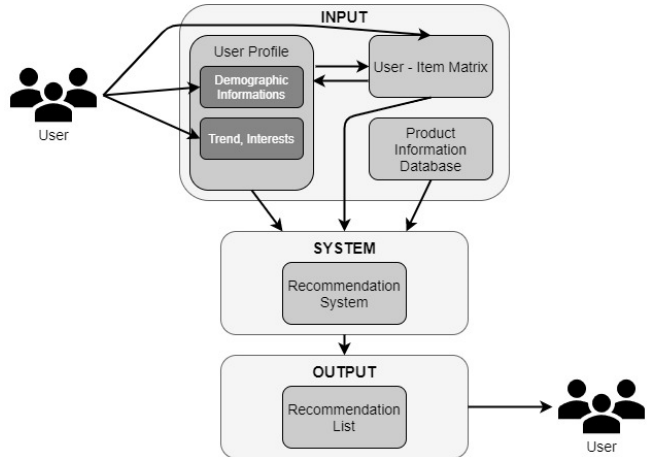
Figure 1. Basic flowchart of recommendation systems.